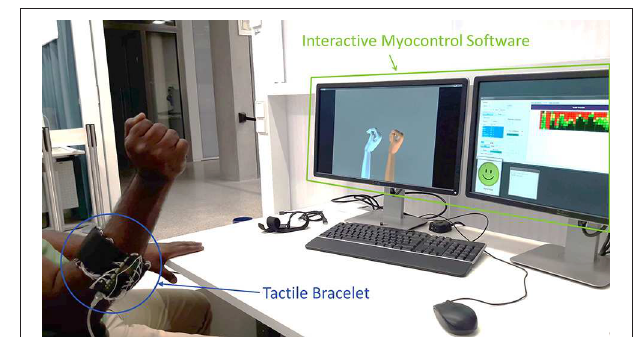
FIGURE 5 | A schematic representation of ROIs and their gradient, obtained from real data. FIGURE 6 | A bird’s-eye view of the